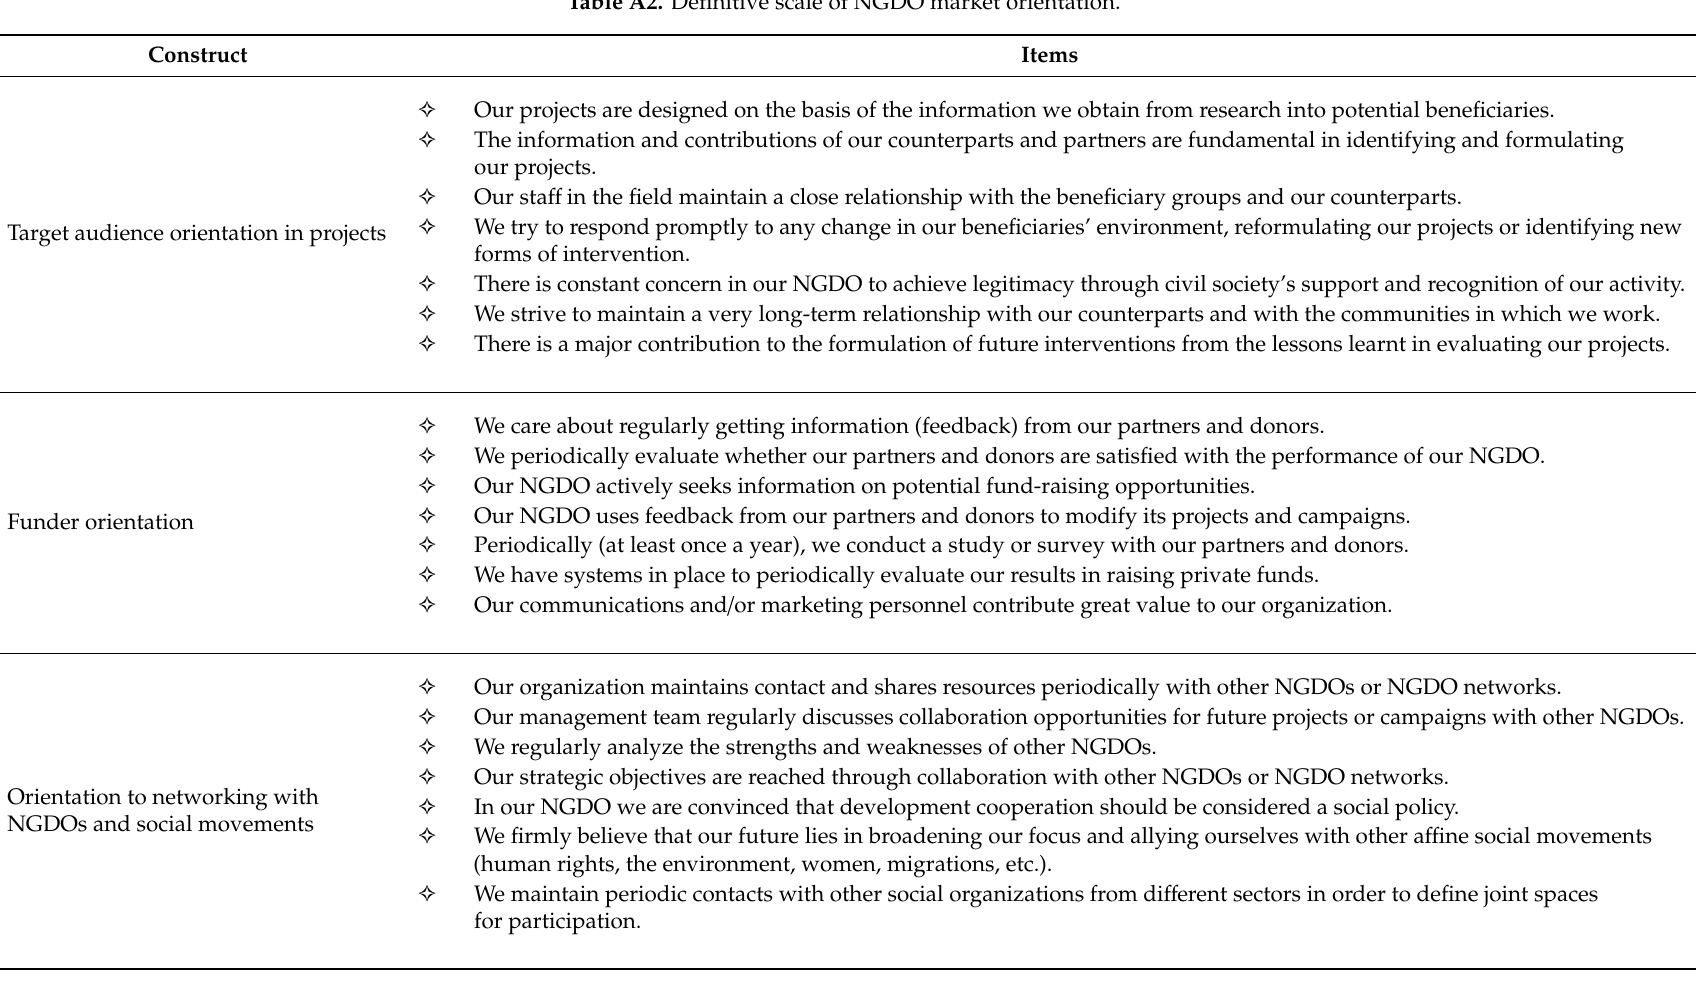
Table A2. Definitive scale of NGDO market